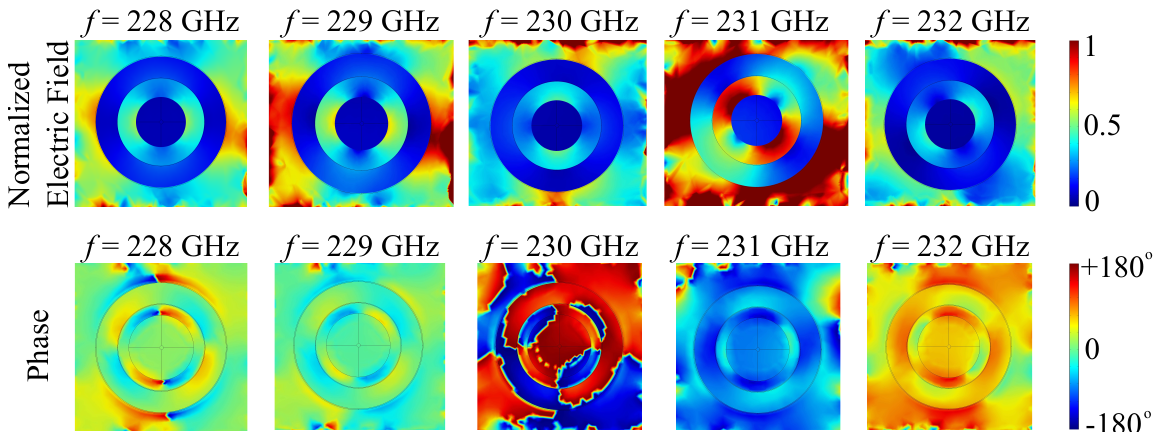
Figure 14. Simulated electric field and in-plane nonlocal phase distributions across the cell element for the silica glass substrate